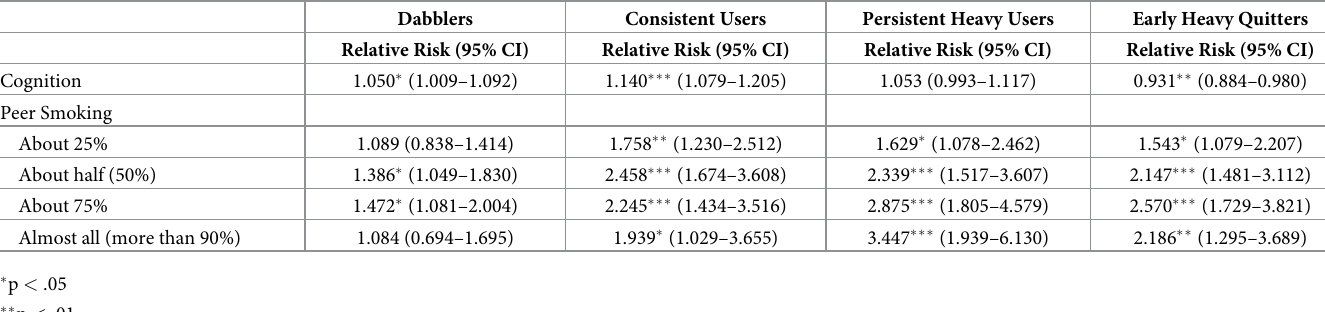
Table 4. Cognitive aptitude and heterogeneous trajectories of marijuana use from age 16 through age 26, using peer smoking (n =